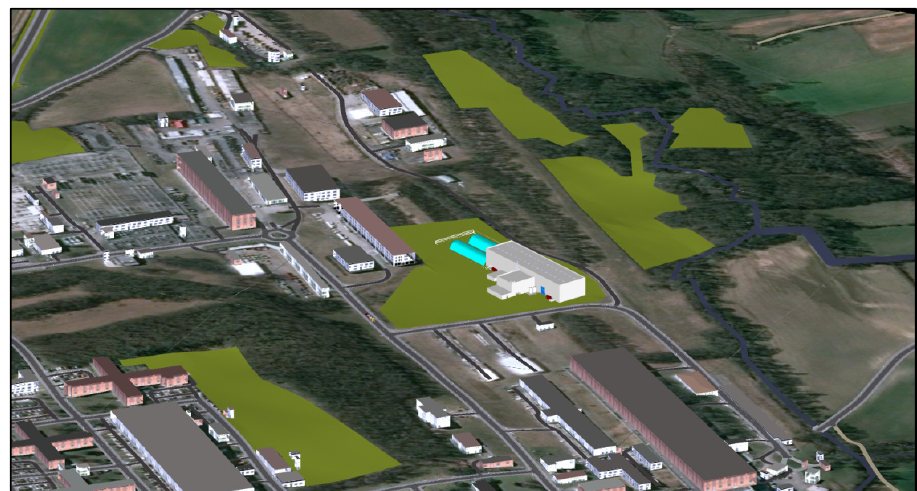
Figure 23. Image of the experimental area with Autodesk Navisworks.